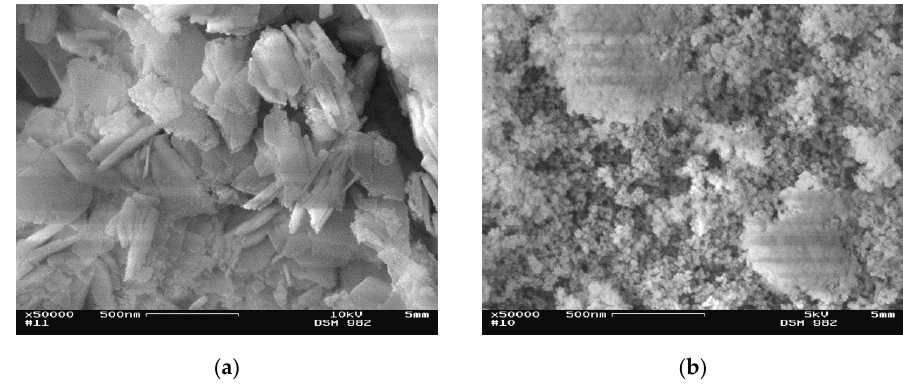
Figure 3. Scanning electron microscopy (SEM) images of ( a ) M1 and ( b ) SiO 2 at 50,000× magnification.